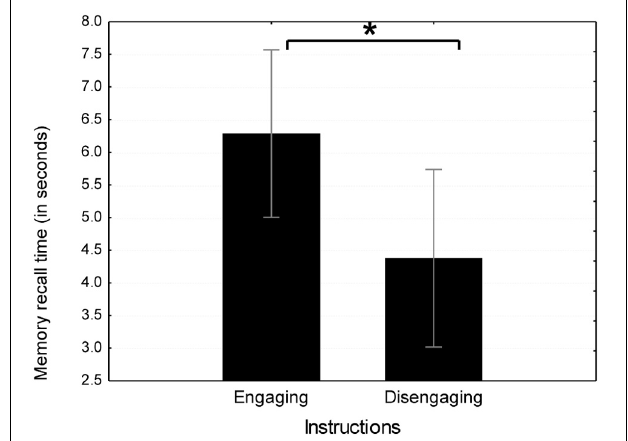
FIGURE 3 | Mean time to generate the first opposite mood memory in emotionally engaging instruction conditions in Study 2. ∗ p < 0 .